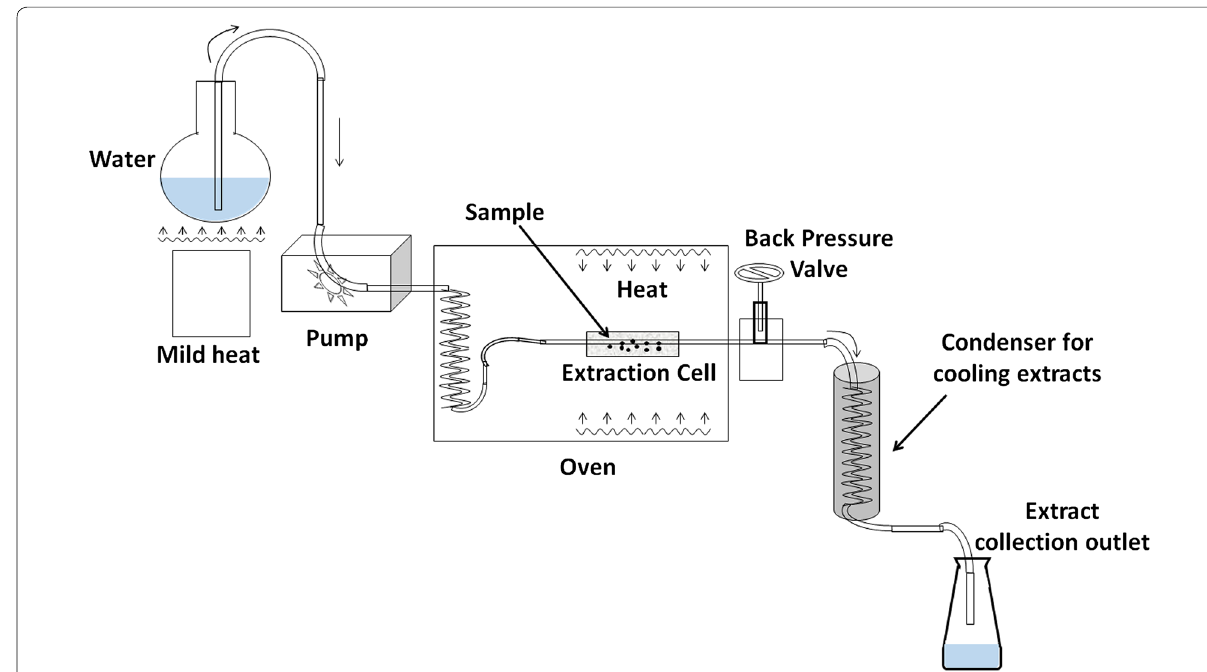
Fig. 1 Diagrammatic representation of our PHWE